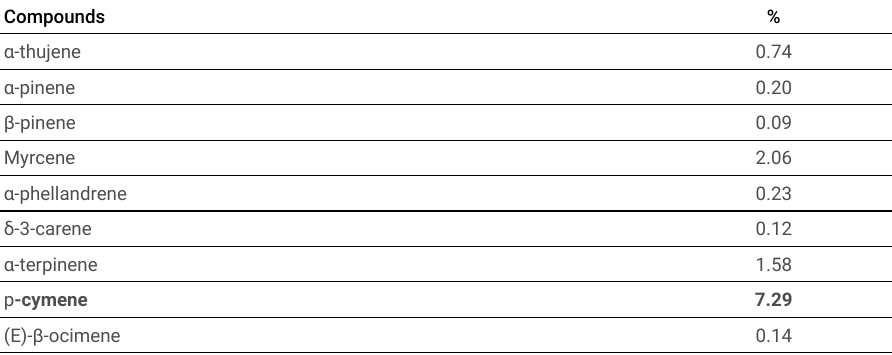
Table 1. Chemical composition of Lippia thymoides essential oil. Compounds % α-thujene 0.74